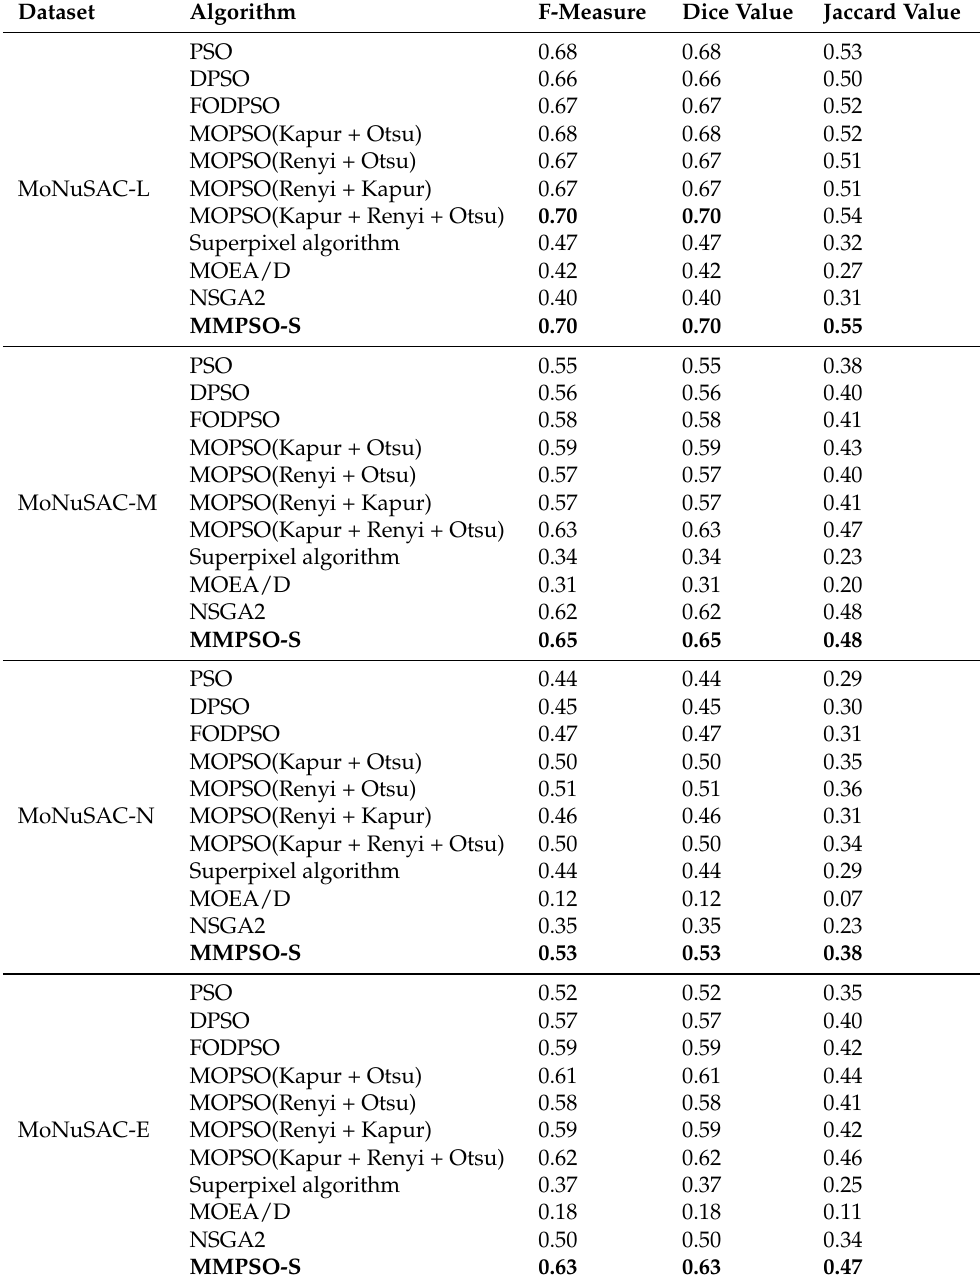
Table 6. Segmentation results of MoNuSAC